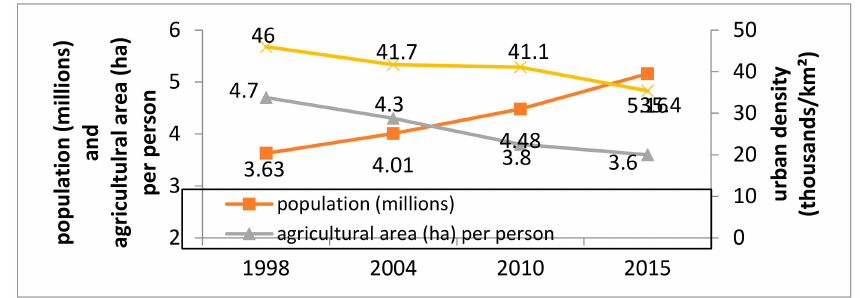
Figure 8. Changes in population, urban population density and agricultural land per person in El-Minya governorate in the period